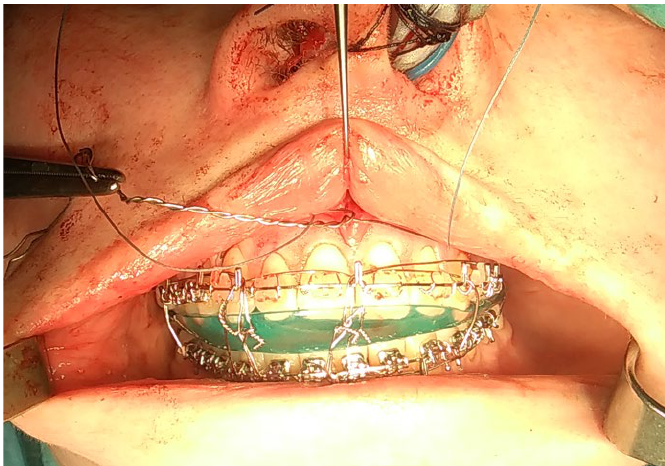
Figure 7. An intraoperative view of occlusion. Because of maxillary plane deviation, at first, it